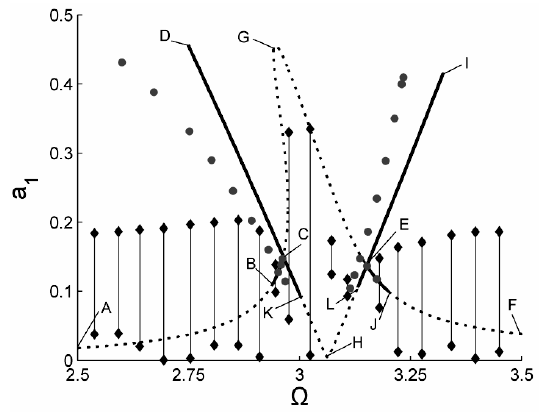
Fig. 6. Analytical and numerical results for the NSC controller re- sponse. Analytical solution: solid line – stable solution, dotted line – unstable solution. Numerical results: circles – amplitude of periodic motion, diamonds – maximum and minimum amplitude of positive part of envelope of quasi-periodic motion; x 0 = 0.01, α 2 =